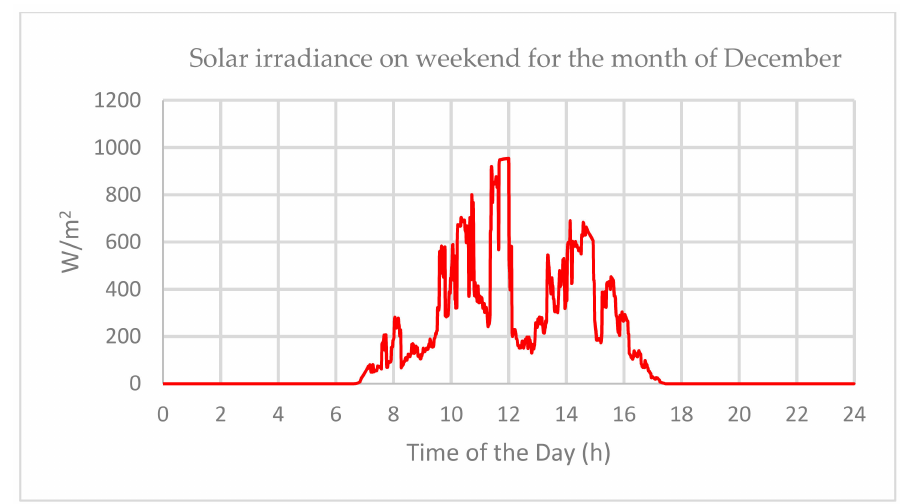
Figure 10. Irradiance on weekend for the month of December over 24